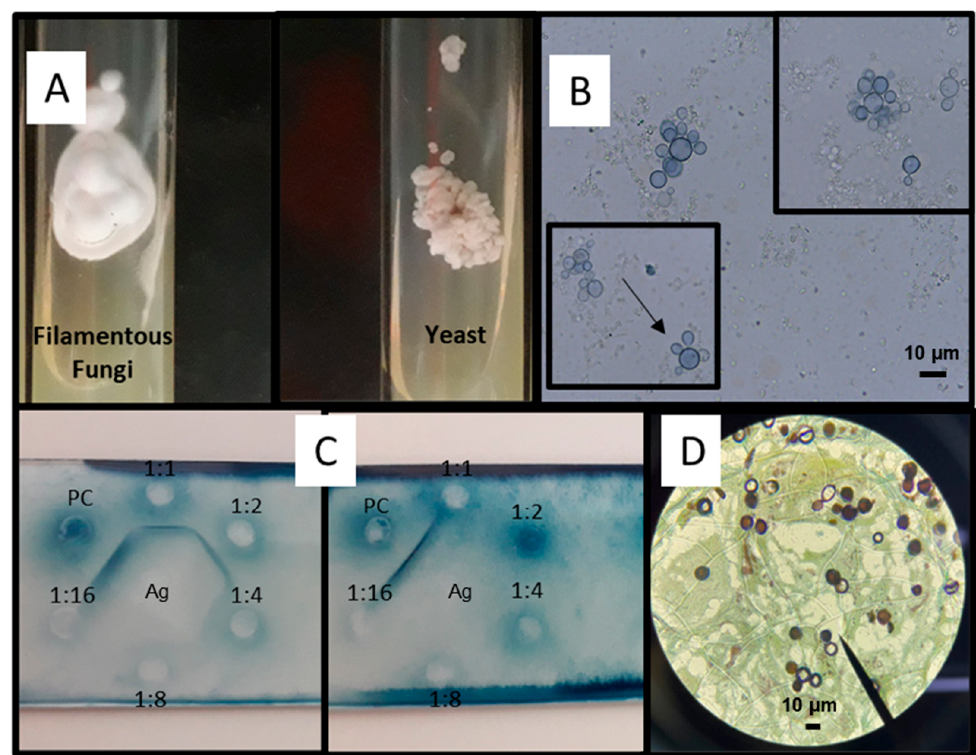
Figure 3. Laboratory diagnosis of Paracoccidioidomycosis. ( A ) Paracoccidioides spp. on Sabouraud agar slants for 14 days at 25 °C (left, filamentous phase) and 37 °C (right, yeast phase); ( B ) yeast form showing multiple budding (5 to 15 µm) seen upon direct examination of a lymph node aspirate, stained with KOH and Parker ink; Bars 10 µm ( C ) double immunodiffusion assay: Paracoccidioides brasiliensis exoantigen (Ag) is in the center well; sera sample from a patient with paracoccidioidomycosis is used in different titrations (wells 1:1 to 1:16) and positive control (PC); positive 1:2 ( left ) and negative ( right ); ( D ) Grocott’s methenamine silver stain showing Paracoccidioides yeast cells. Bars 10 µm